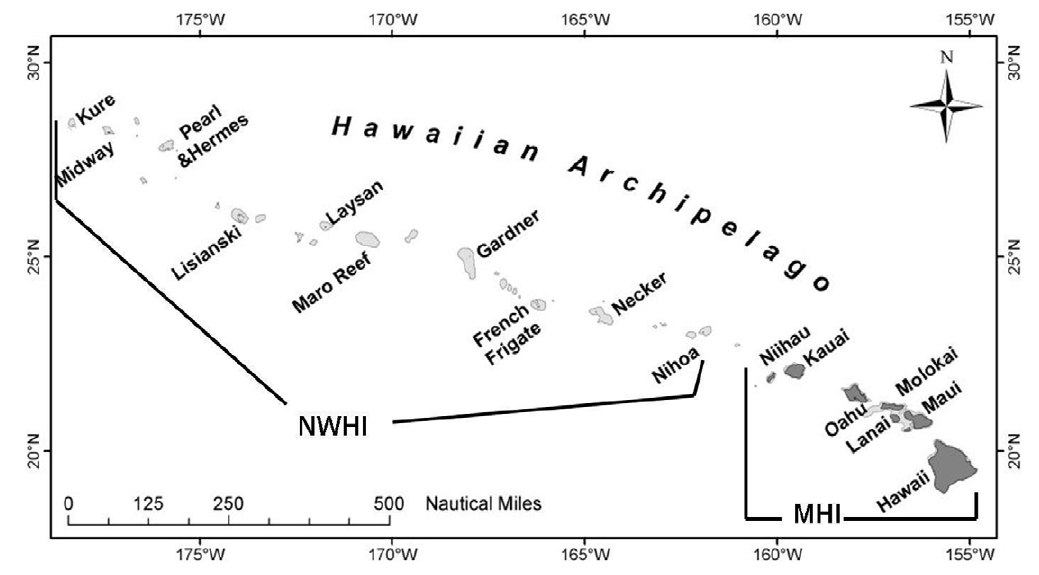
Figure 1. Map of the Hawaiian archipelago.